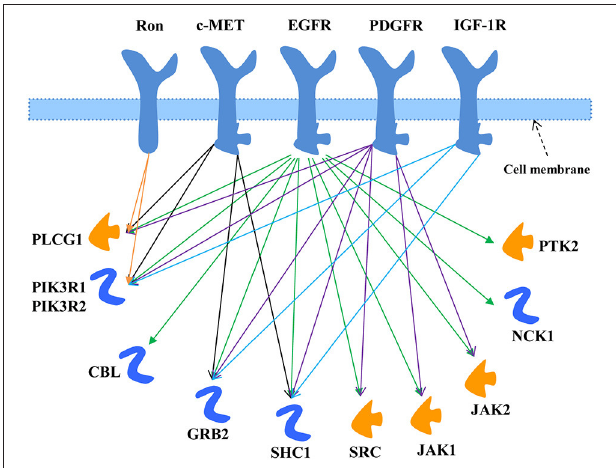
FIGURE 1 | EGFR signaling pathway modified from MetaCore ® . The downstream molecules shared with the other TKRs (c-MET, Ron, PDGFR, and IGF-1R) were marked by arrowed lines with different colors.